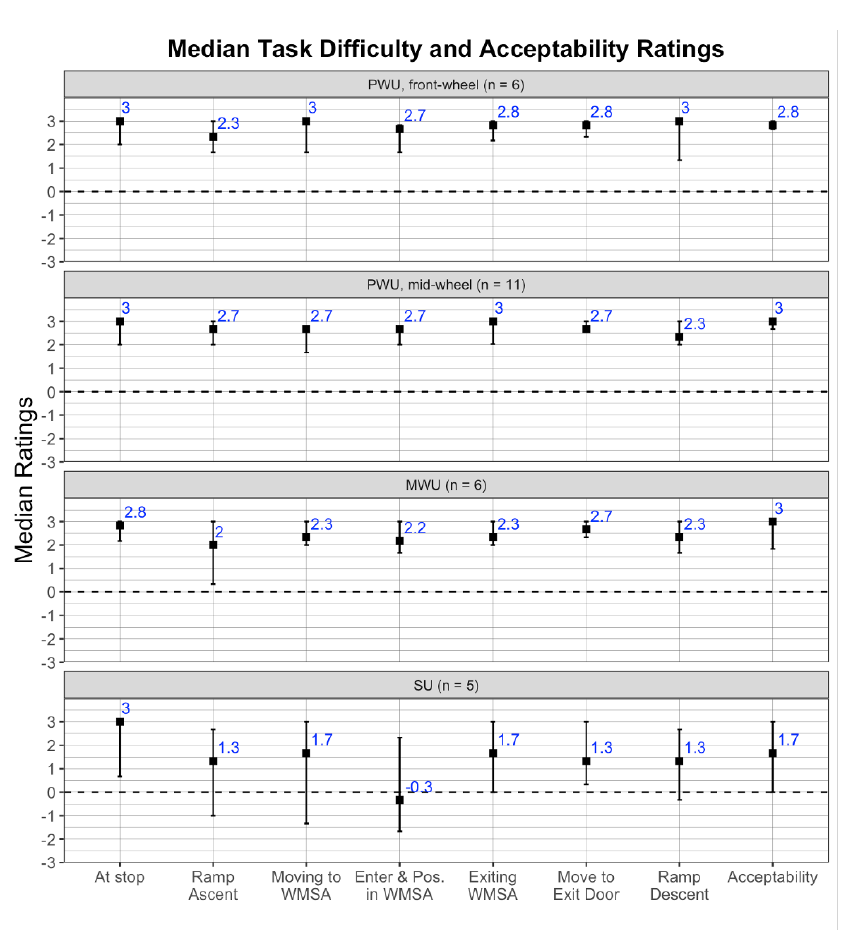
Figure 5. Medians ( (cid:4) ) and 90% confidence intervals for task difficulty ratings ( − 3 = very difficult, 3 = very easy) and accessibility ratings ( − 3 = very unacceptable, 3 = very acceptable) averaged across 3 bus trips per participant and stratified by user group: mid-wheel (n = 6) and front-wheel (n = 11) drive powered wheelchair users (PWU), manual wheelchair users (MWU; n = 6), and scooter users (SU; n =